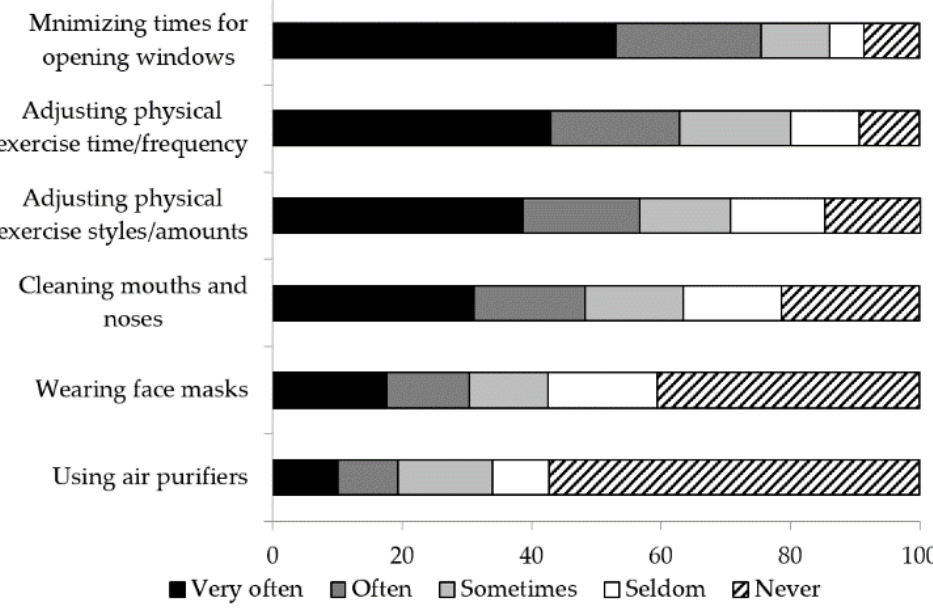
Figure 3. The distribution of risk reduction behavior of the study population.